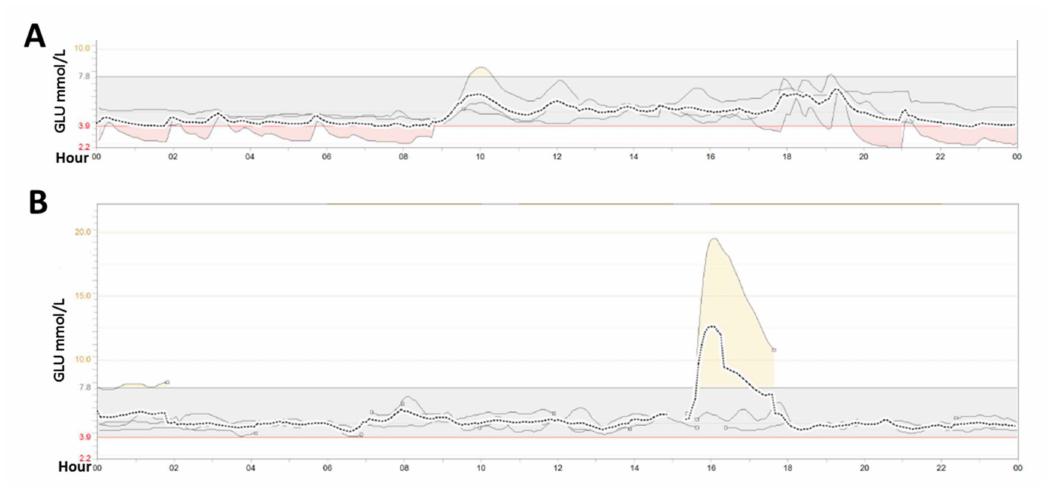
Figure 2. The dynamic blood glucose monitoring results. The blood glucose range was continuously detected for three days by an audiomonitor (Minimed Paradigm 722, Medtronic). ( A ) Hypoglycemia (<3.9 mmol/L) of Case 2 mainly occurred from 8:00 pm to 8:00 am; ( B ) Though no hypoglycemia was detected in Case 4, he did not appear to have a high postprandial blood glucose peak, which could be induced by oral glucose intake (the peak in 16:00–18:00). The dashed line represents the mean value of glucose over three days. The three solid line represents the results of each day monitoring result, respectively. The small circle after the solid line means monitoring interruptions because of non-cooperation of the patient. GLU: